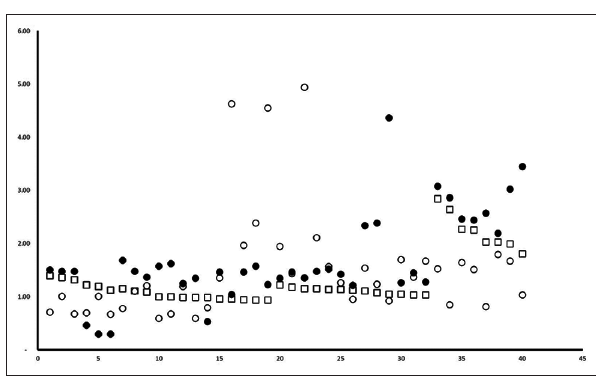
Figure-1: The scattered plot of bovine growth hormone level of serum of Bali cattle from Bali (filled circle), Sumbawa (unfilled circle), and Nusa Penida (unfilled box).